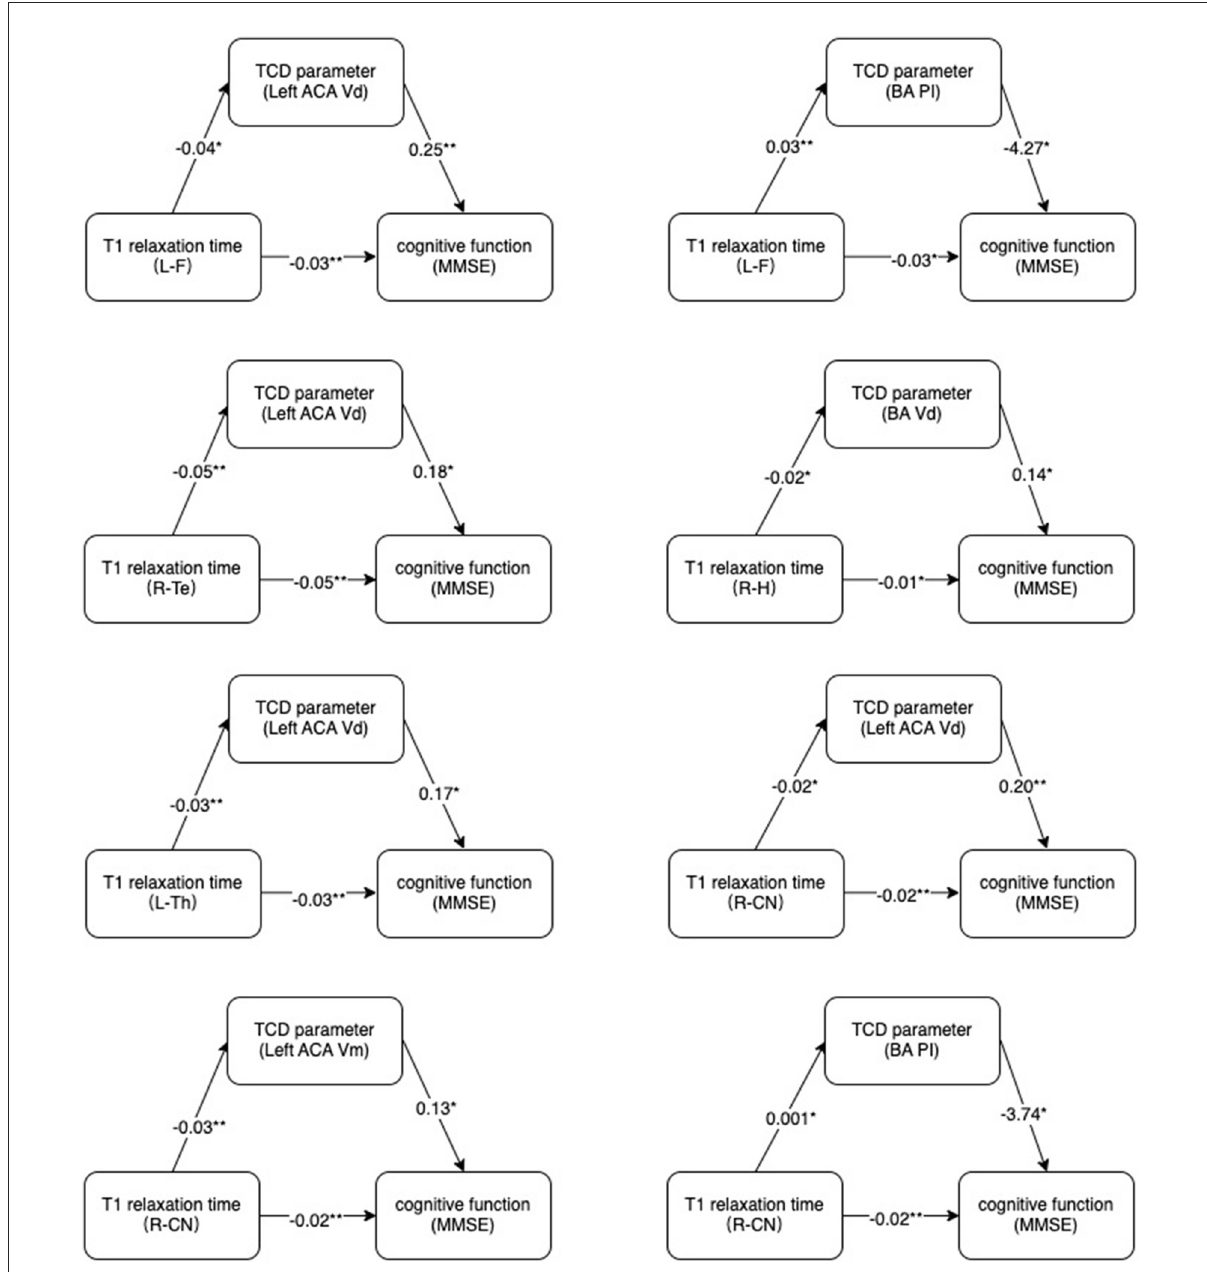
FIGURE4 Mechanism diagram. Hypothesized direct and indirect pathways linking brain microstructure (T1 relaxation times) to cognitive impairment (MMSE) through a mediator (TCD parameters).MMSE, Mini-Mental State Examination. * p < 0.05, ** p < 0.01.